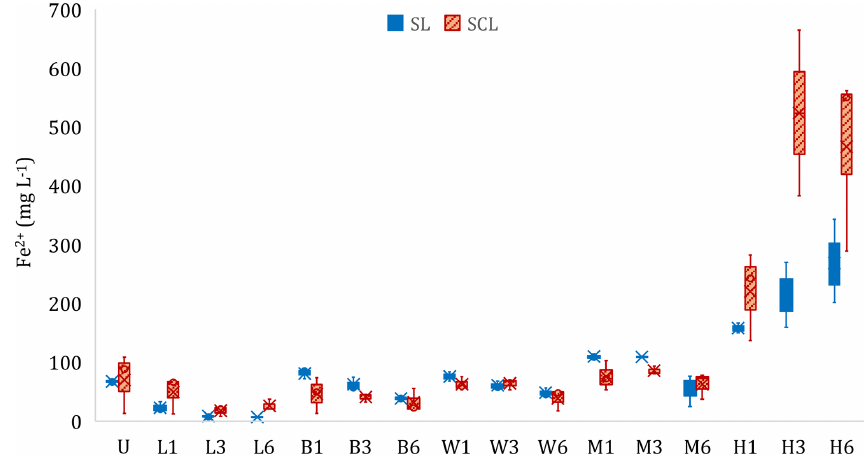
Figure 3. Experiment 1b. Concentration of ferrous iron (Fe 2 + ) in the liquid phase at the end of the incubation period. Microcosms receiving different organic amendment types and levels in sandy clay loam (SCL) and sandy loam (SL). U: no-amendment control, L: Leafgro (yard waste), B: biosolids, W: wood chips, M: manure, and H: hay. Numbers signify treatment level (1, 3, or 6 times the amount of organic matter equivalent to 60yd 3 per acre to a depth of 6in.). Different lowercase letters signify differences ( p < 0.05) based on contrasts compared to U, and brackets signify that all results in the bracketed group were not statistically different. H increased total Fe 2 + production compared to U in both soils, and L decreased total Fe 2 + production compared to U (SL only).